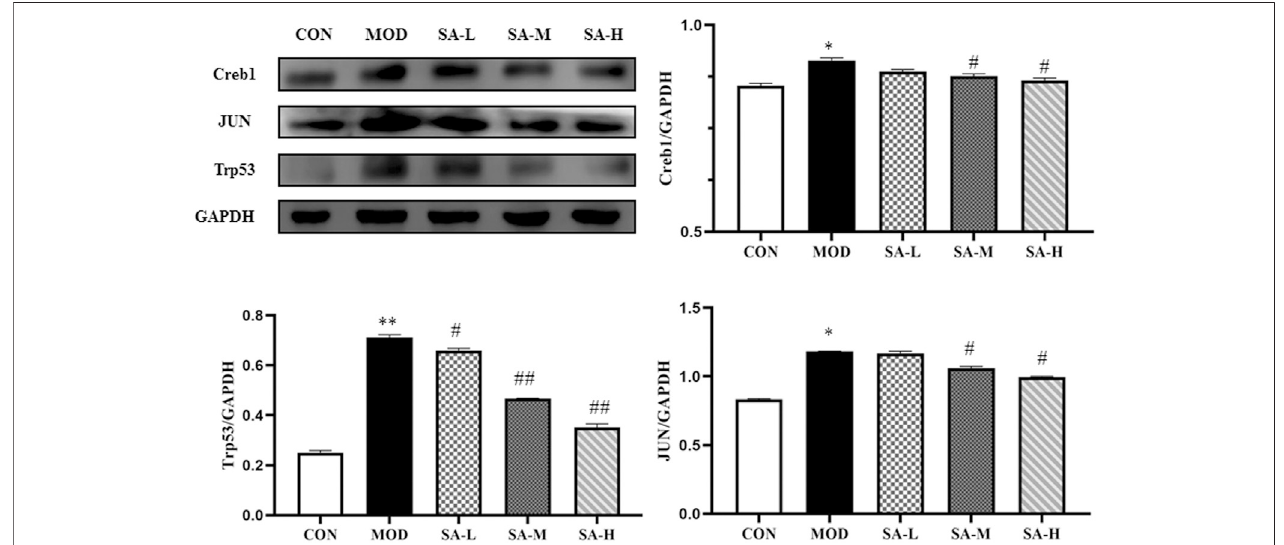
FIGURE 7| Effects ofSA on the expression ofJun, Trp53 and Creb1 proteins. Notes: Groups: CON, control group; MOD, model group; SA-L, Schisandrol A low- dosegroup;SA-M,SchisandrolAmedium-dosegroup;SA-H,SchisandrolAhigh-dosegroup.Allthevalueswereexpressedasmean ± standarddeviation( n (cid:1) 3).*: p < 0.05, vs . CON; **: p < 0.01, vs . CON; #: p < 0.05, vs . MOD; ##: p < 0.01, vs .